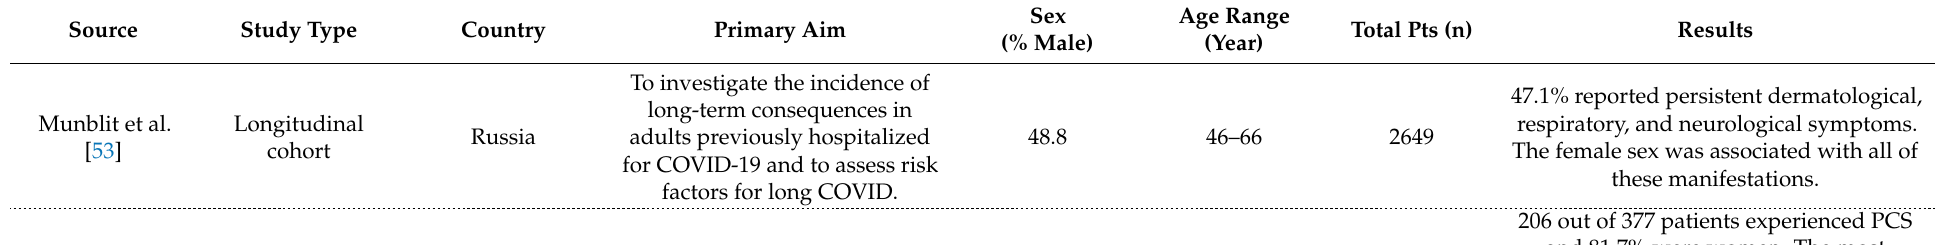
Table 2. Studies on sex-related differences in long